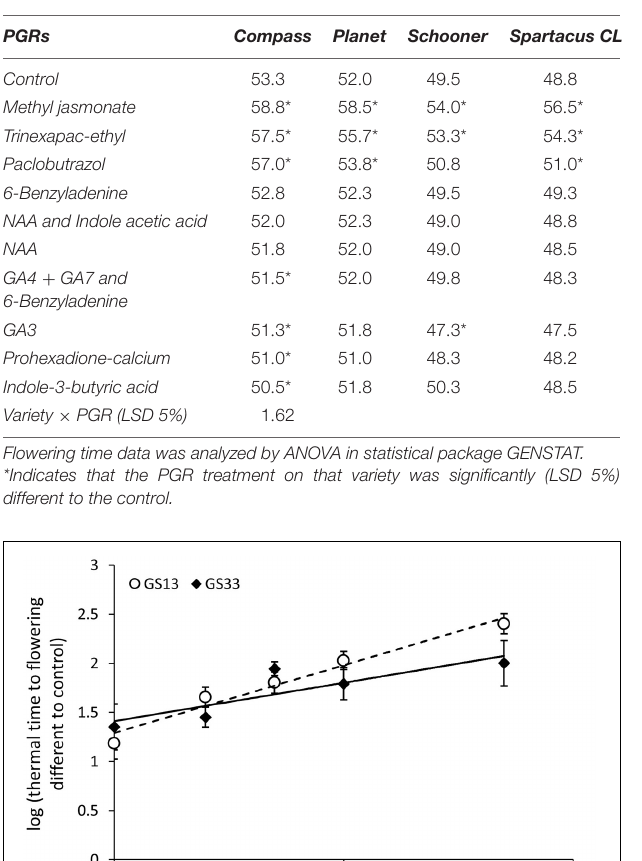
TABLE 3 | The relative number of days to flowering for different barley varieties in the glasshouse when sprayed at GS13 and GS31 with different plant growth regulators (PGRs).